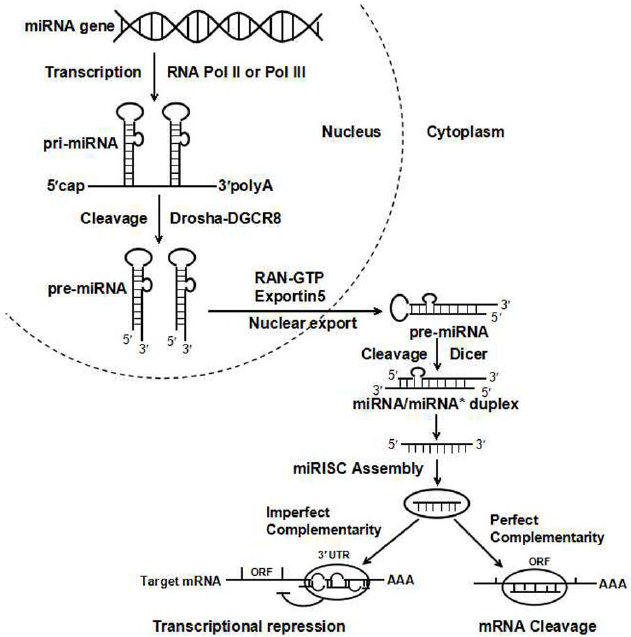
Figure 1. MiRNA biogenesis and posttranslational silencing mechanism. The miRNA maturation includes the production of the primary miRNA transcript (pri-miRNA) by RNA polymerase II or III and cleavage of the pri-miRNA by Drosha in the nucleus. Pre-miRNAs are transported to the cytoplasm by Exportin 5 and are processed into miRNA/miRNA* duplexes by Dicer. Only one strand of the miRNA/miRNA* duplex is processed into the RNA-induced silencing complex (RISC), which subsequently acts on its target mRNAs through mRNA cleavage, translational repression or deadenylation, depending on the level of complementarity between the miRNA and its targets. ORF, open reading